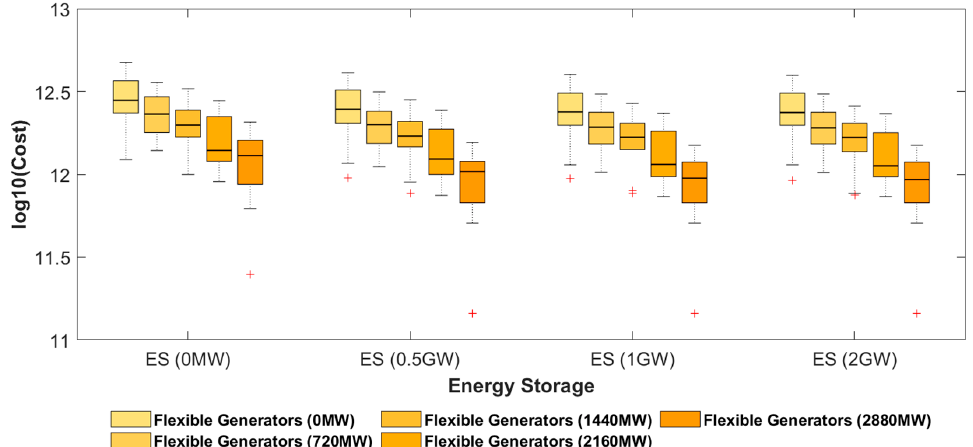
Figure 13. Cost comparison of multi-scenario unit scheduling in autumn.